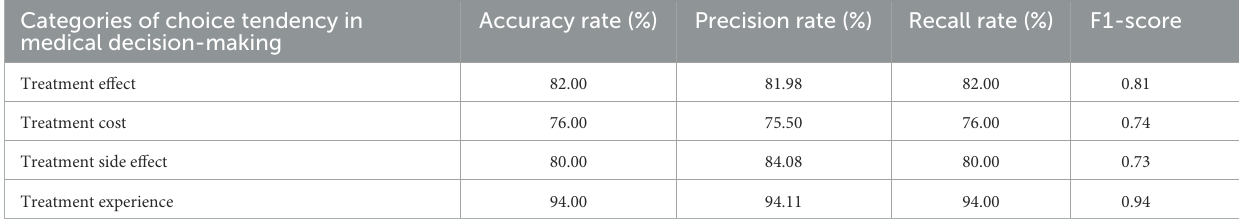
TABLE 5 Model evaluation effect of support vector machine algorithm.